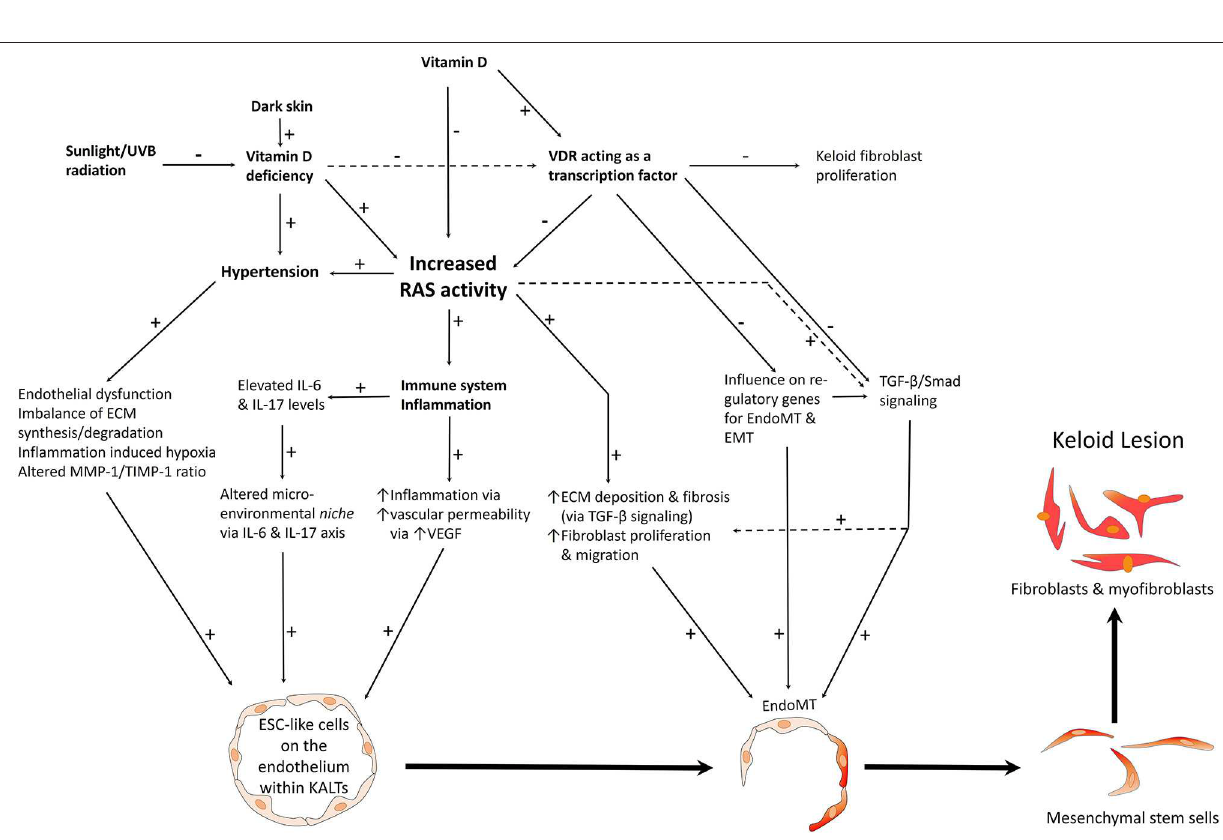
Frontiers in Surgery |